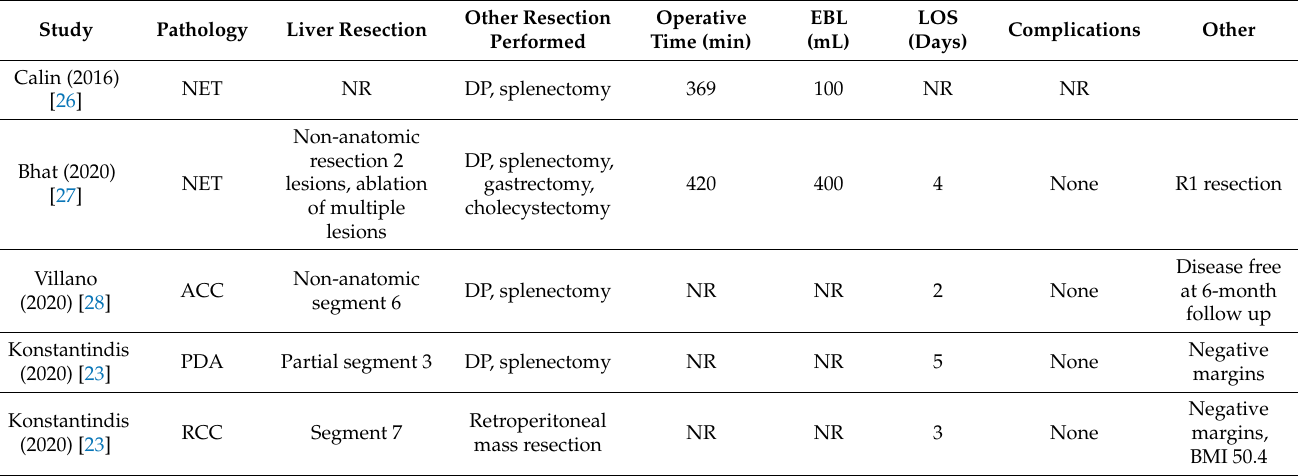
Table 2. Summary of simultaneous robotic hepatic and non-colorectal resections for syn- chronous